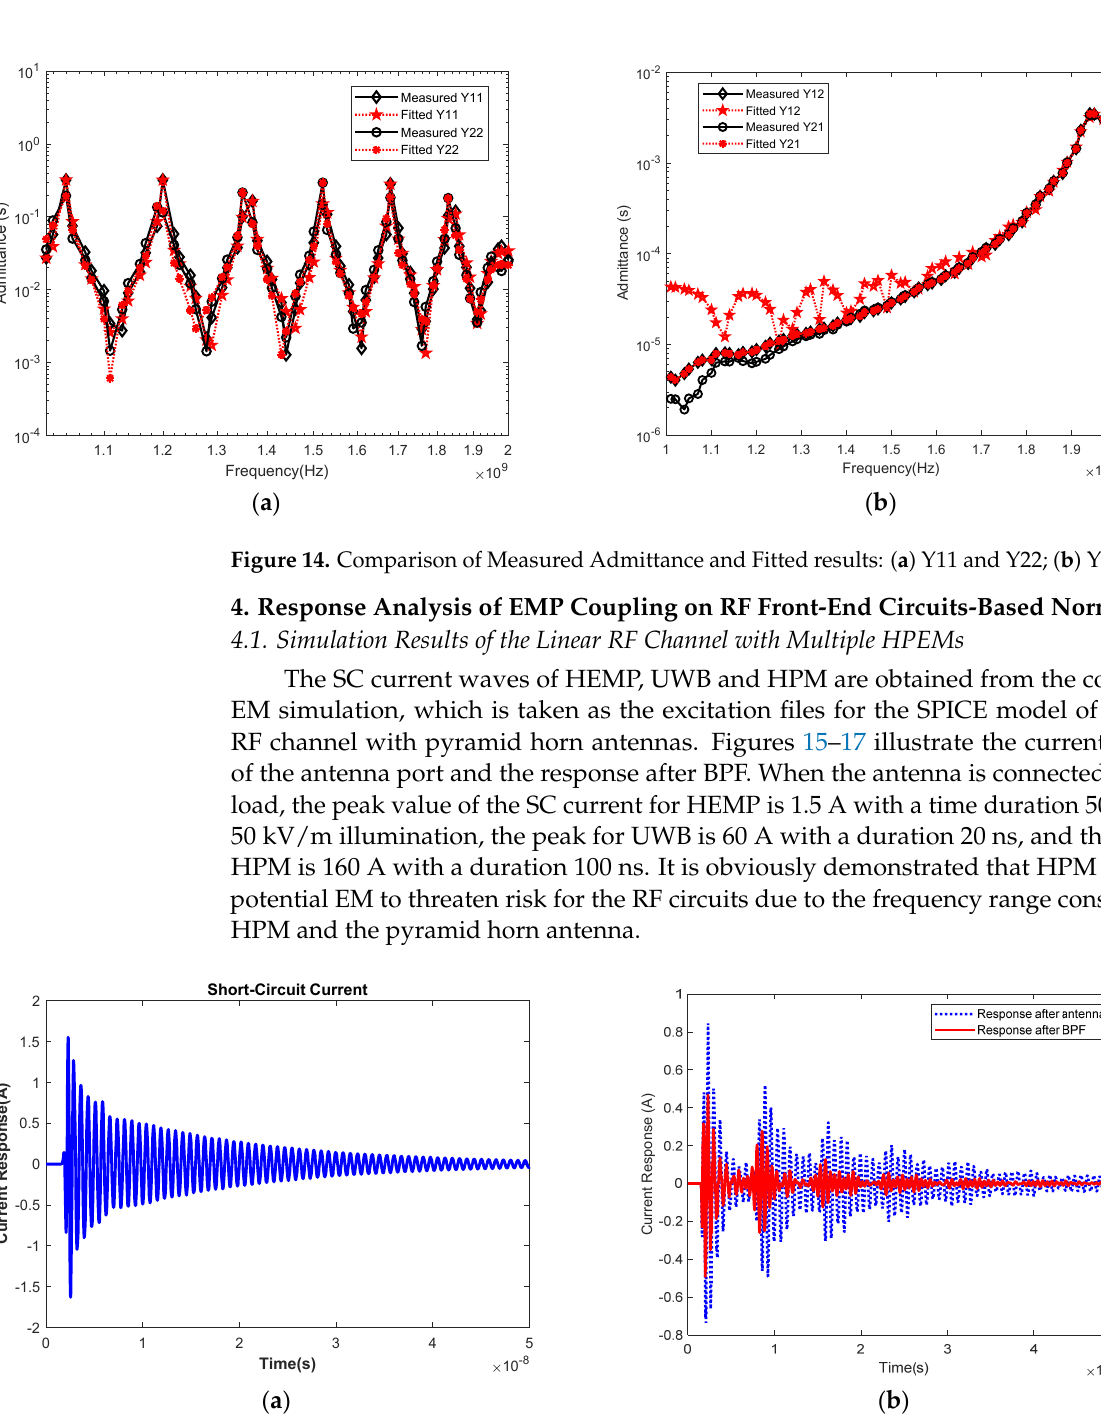
Figure 15. Coupling response excited by HEMP: ( a ) SC current; ( b ) Responses. When the BPF is connected to the antenna port instead of the SC load, the current response of the antenna port has changed a lot due to the different impedance characteristics of the load connected to the antenna. It is known that the peak of the current response after the antenna for HEMP is reduced to 0.83 A, the peak for UWB is 46.23 A, and the peak for HPM is reduced to 142.96 A.